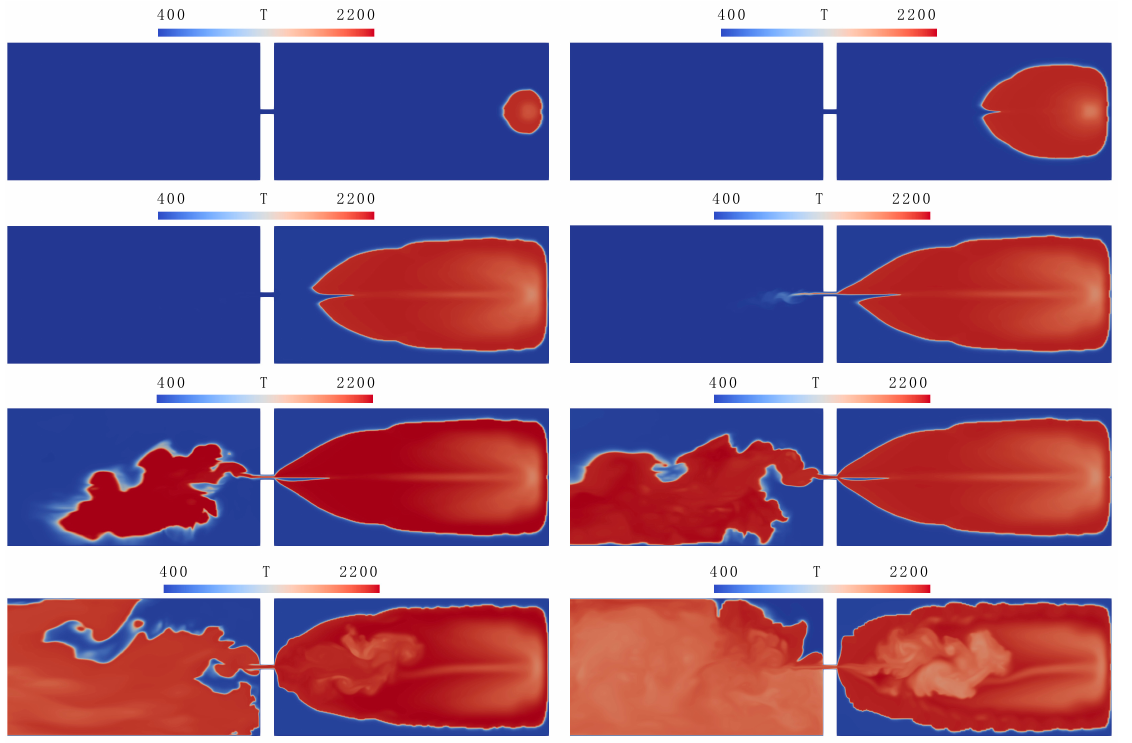
Figure 4. Flame penetration through a hole: temperature distributions in the symmetry plane z = 0 at times 10, 20, 30, 32, 33, 33.5, 36, and 40 ms ( top to bottom , left to right ).